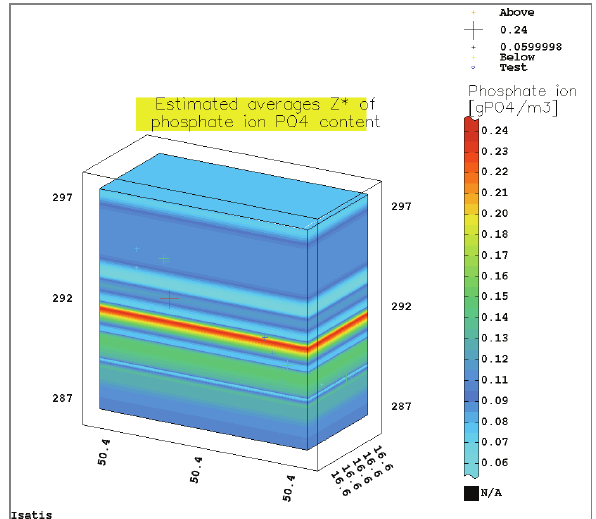
Fig. 27. Block diagram of estimated averages Z * distribution of phosphate anion content [g